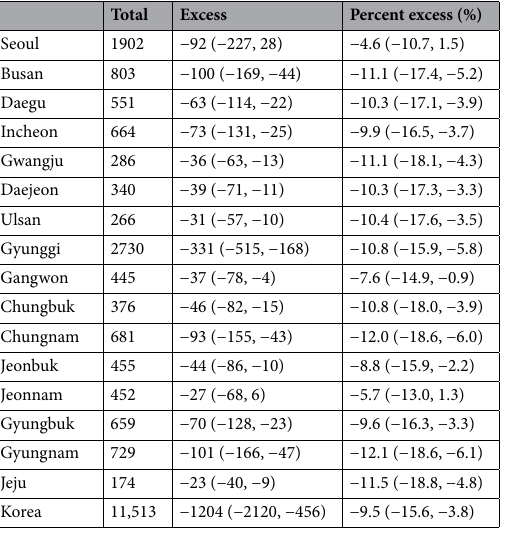
Table 2. Total number, estimated excess (95% eCI), and percent excess (95% eCI) of suicide during the period February 18–December 31, 2020 in Korea by region. We computed empirical confidence intervals (eCIs) at 95% by Monte Carlo simulation. eCI empirical confidence interval.